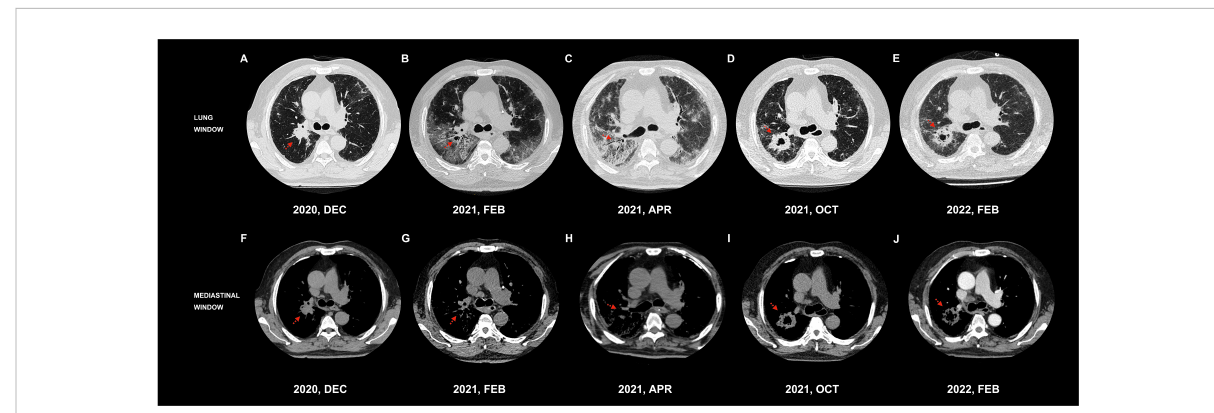
FIGURE 1 Chest CT of tracheal carina level in the lung and mediastinum windows. dynamic changes of the space-occupying lesions. (A) / (F) A space- occupying lesion (2.9 × 2.6 cm) in the upper lobe of the right lung. (B) / (G) The primary foci shrank signi fi cantly and was surrounded by GGOs and consolidation shadow. (C) / (H) Multiple GGOs, reticulation, grid lesions, and traction bronchiectasis in the dominant lobe around the primary foci with patchy lesions in the opposite lobe. (D) / (I) A recurred lobulated mass (5.0×2.6 cm) in the upper lobe of the right lung. (E) / (J) Mildly reduced lesion (4.2×4.3